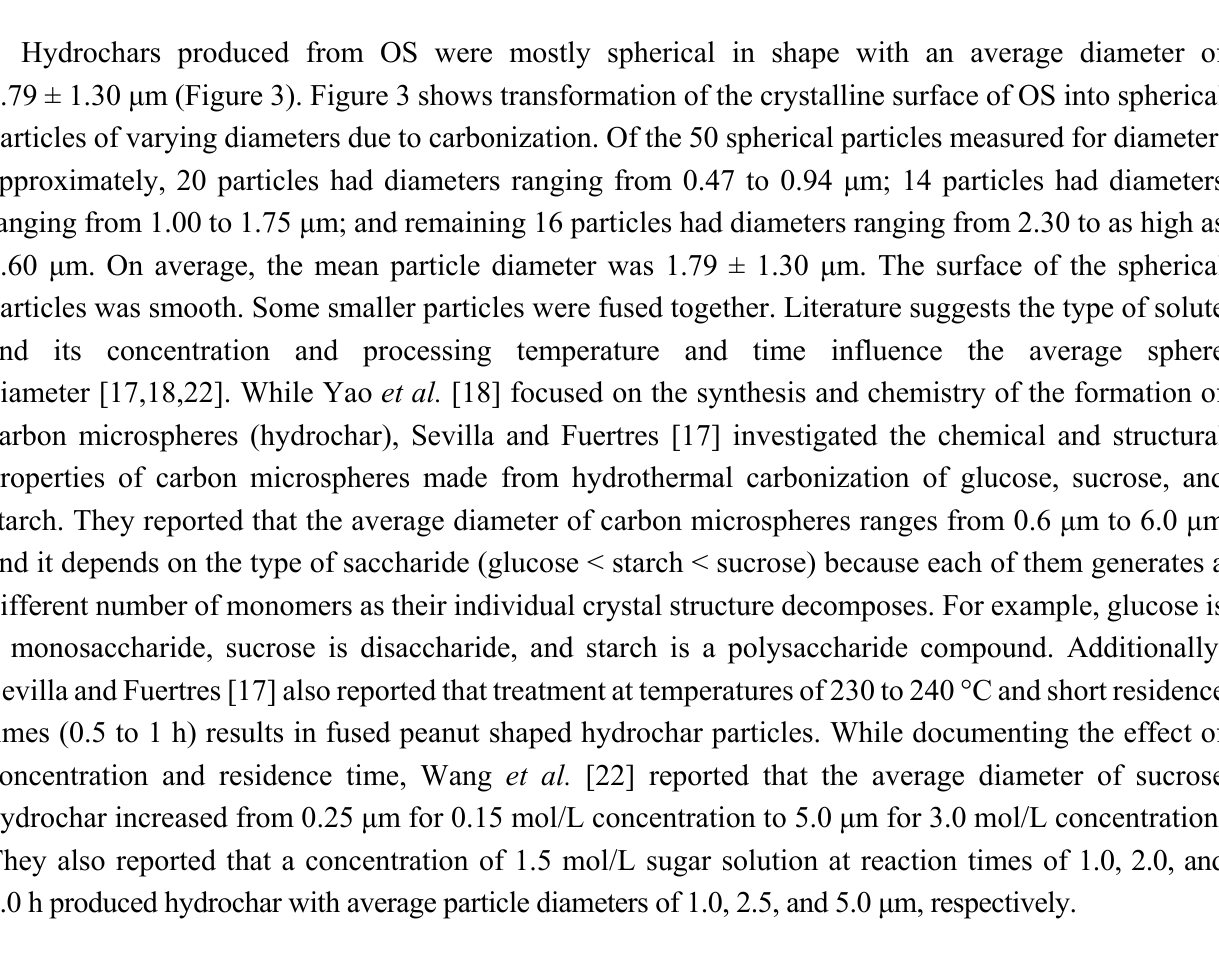
Figure 3. SEM pictures of ( a ) freeze-dried osmotic sugar solution (OS) ( b ) hydrochar made from OS through hydrothermal carbonization at 250 °C with 30 min of reaction